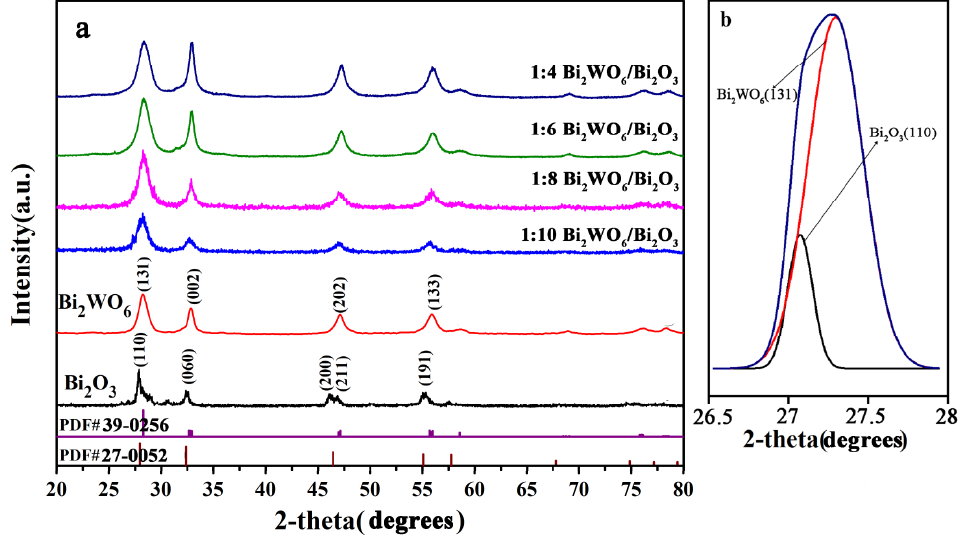
Figure 1. ( a ) XRD metal oxide patterns for Bi 2 O 3 , Bi 2 WO 6 , and Bi 2 WO 6 /Bi 2 O 3 nanocomposite with different coupling rates. ( b ) Gaussian deconvolution peak fitting for Bi 2 O 3 (110) and Bi 2 WO 6 (131) of 1:8 sample.